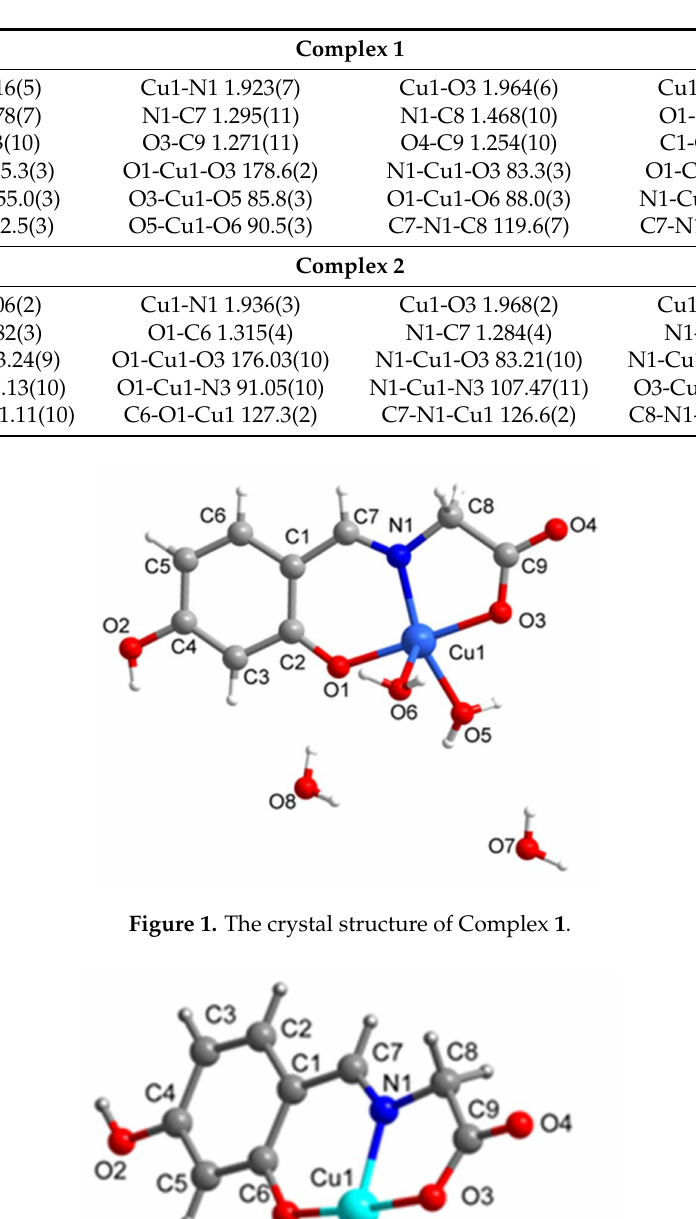
Table 2. Selected bond distances (Å) and bond angles ( ◦ ) for Complexes 1 and 2 .